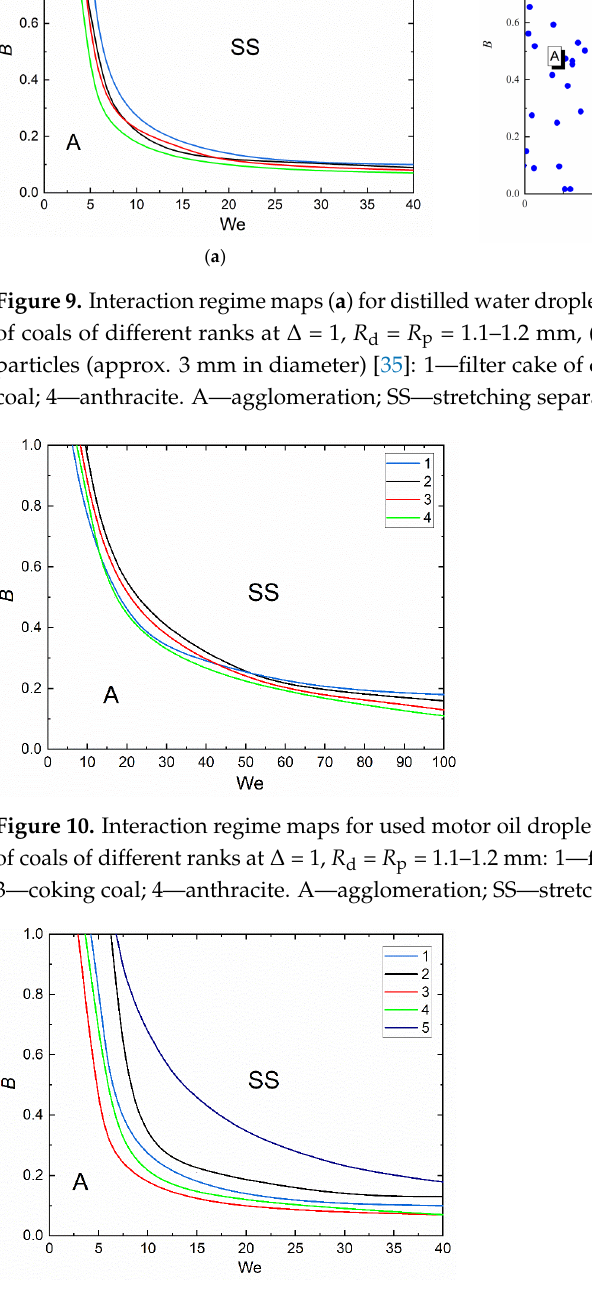
Figure 11. Interaction regime maps of distilled water droplets colliding with carbonaceous particles of coals of different ranks at Δ = 1, R d = R p = 1.1 – 1.2 mm: 1 — dry particle of coking coal filter cake; 2 — wetted particle of coking coal filter cake; 3 — dry particle of anthracite; 4 — wetted particle of anthracite; 5 — data of Pawar et al. [35]. A — agglomeration; SS — stretching